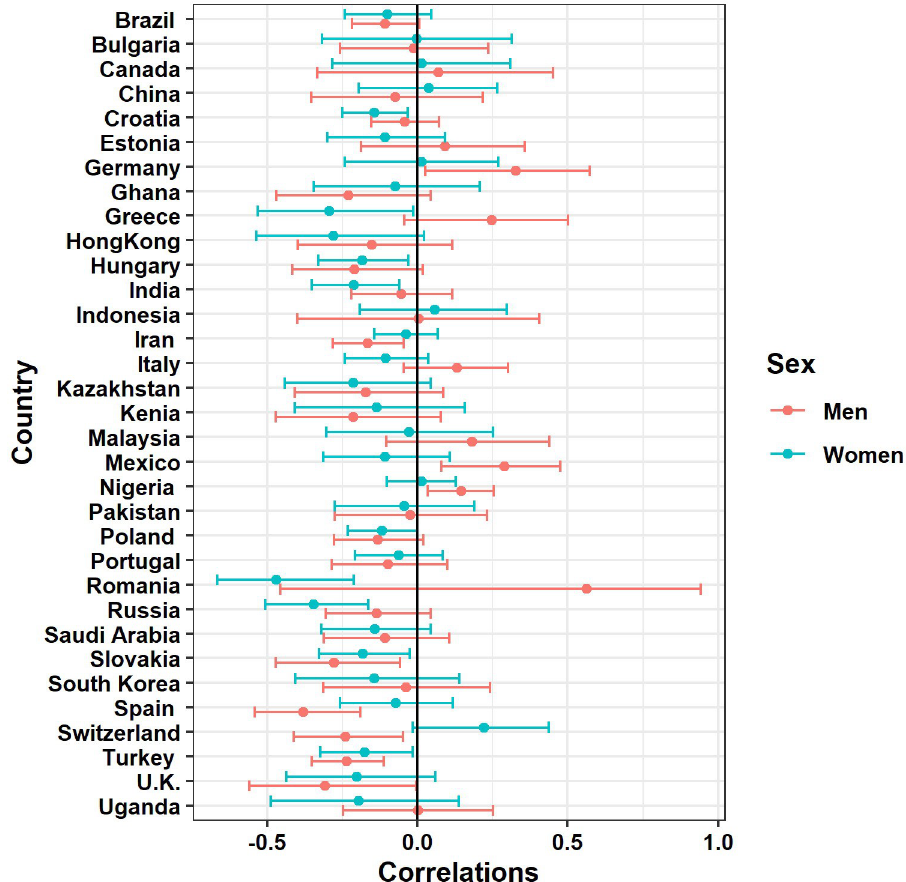
Fig 1. Relationships (Pearson r ) and 95% confidence intervals between the number of children and marital satisfaction with respect to sex and countries. individualism ( β = 0.064, p < 0.001) were positively related to marital satisfaction. Marriage